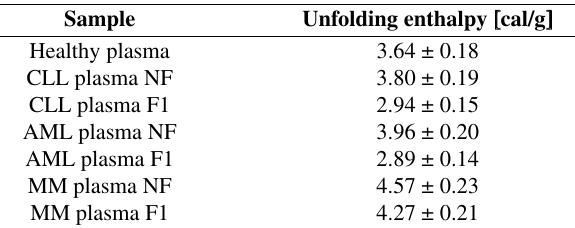
Table 1. Denaturation enthalpies of plasma from healthy individual and from blood plasma of diseased individuals. NF–non-fractio- nated plasma; F1–flow-through plasma fraction. Experimental er- ror due to baseline correction is ± 5%.